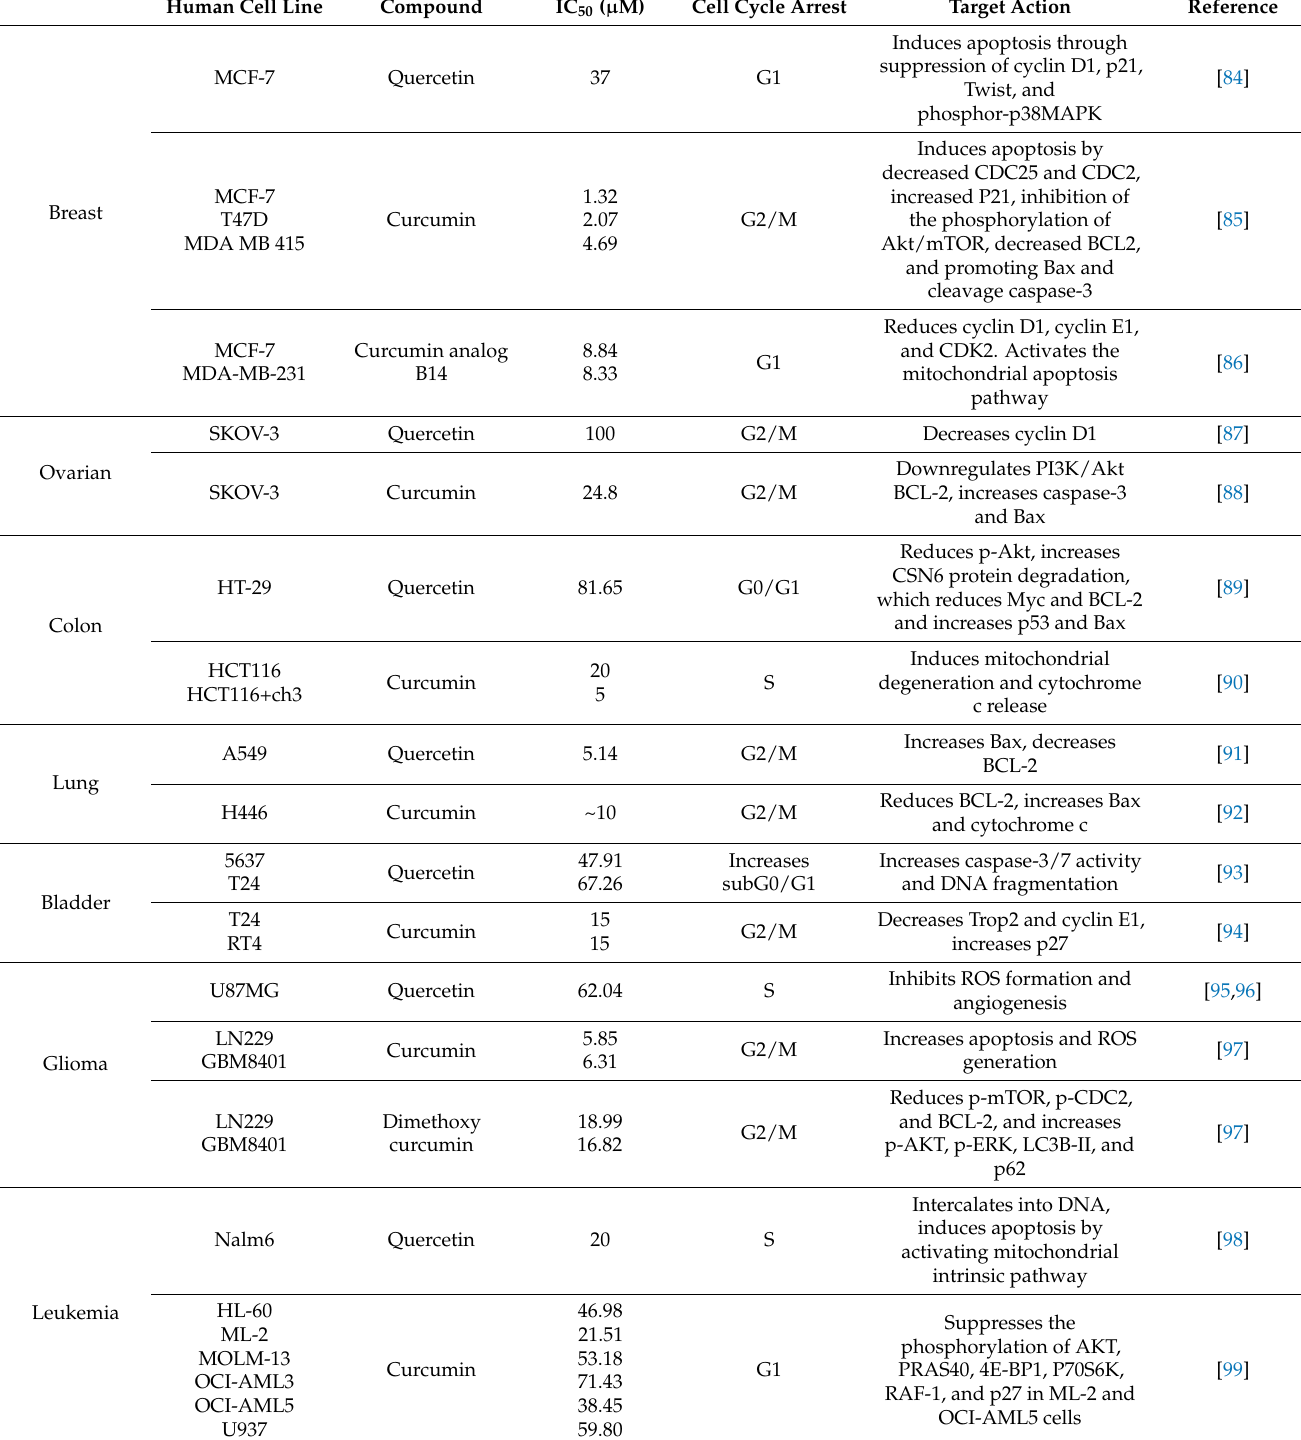
Table 1. Cytotoxicity of quercetin and curcumin in cancer cell